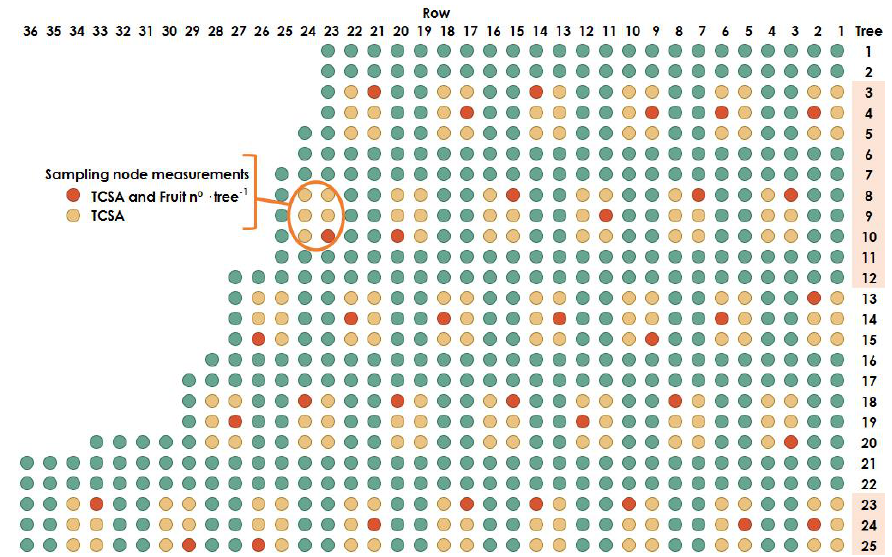
Figure 2. Close-up schematic of the upper part of VAL_02 orchard, indicating the sampling grid. In summer, after thinning and before harvest, trunk size (TCSA, cross-sectional area 15 cm above grafting point, cm 2 ) was recorded on each tree in the SN, whereas fruit number (fruit·tree − 1 ) was recorded in the tree with TCSA closer to the average of the six trees in the SN.